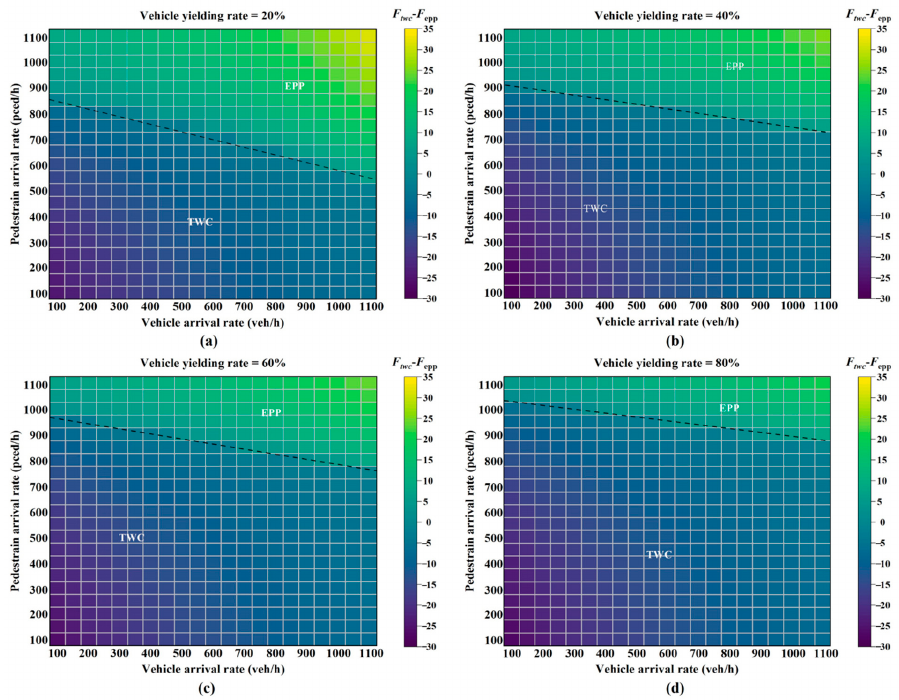
Figure 8. Phase setting and traffic demand under different vehicle yielding rates in the second condition: ( a ) vehicle yielding rate, 20%; ( b ) vehicle yielding rate, 40%; ( c ) vehicle yielding rate, 60%; ( d ) vehicle yielding rate, 80%.